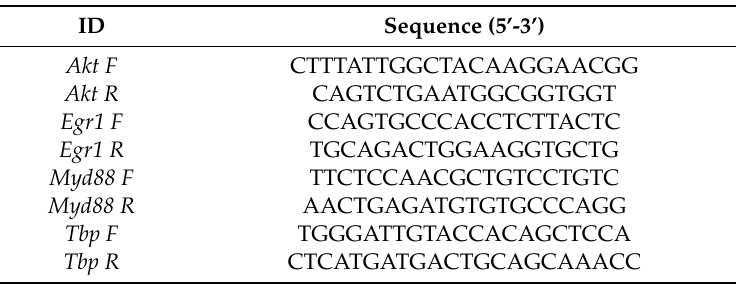
Table 2. Primers used for quantitative